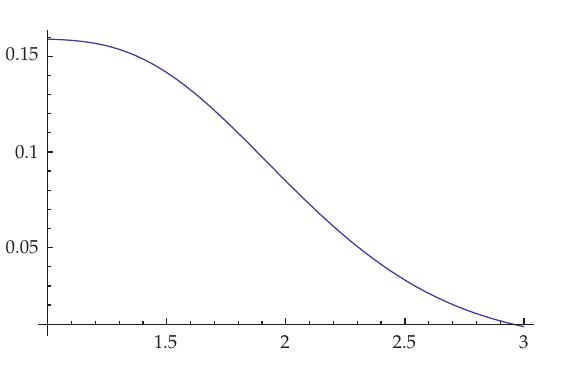
(cid:21) 2 exp (cid:3) − (cid:3) π 2 / 8 (cid:4)(cid:3) 2 k (cid:10) 1 (cid:4) 2 (cid:3) r/ 2 (cid:4) 2 (cid:4)(cid:7) 2 k (cid:5) 0